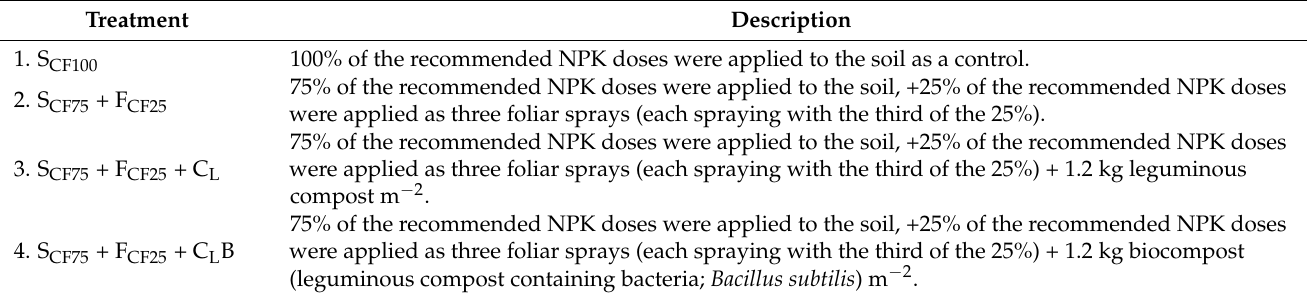
Table 1. The description of the experimental fertilization treatments for soil and plant. Treatment